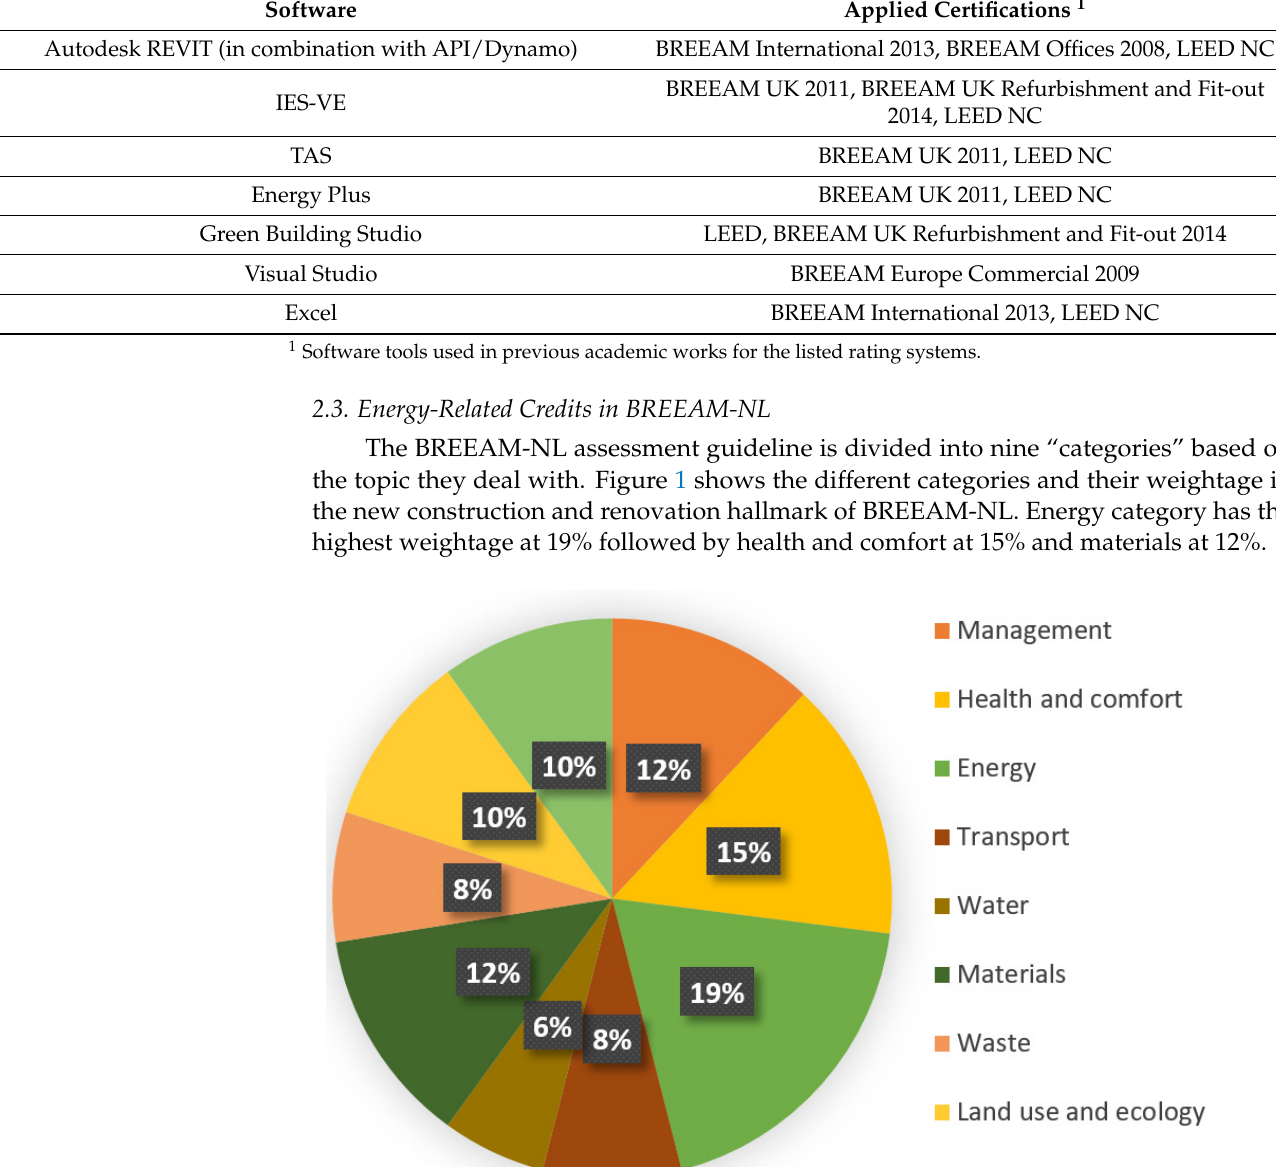
Table 1. Common software tools used for sustainability evaluations (derived from Carvalho et al. [5]). Software